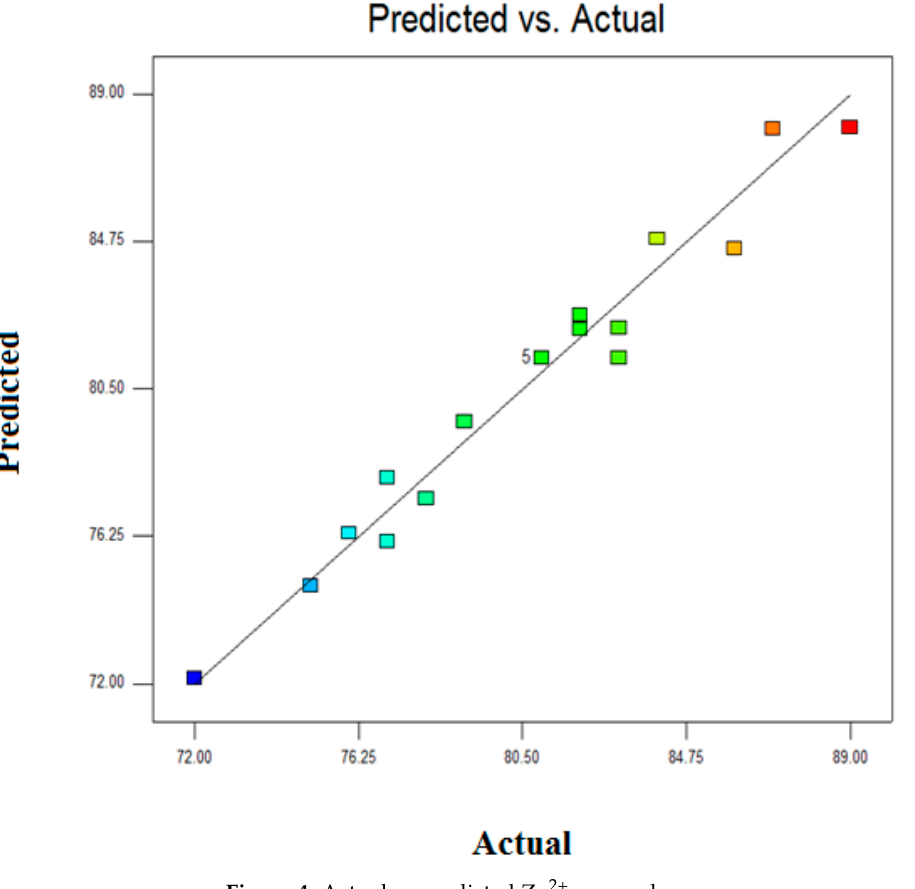
Figure 4. Actual vs predicted Zn 2+ removal.